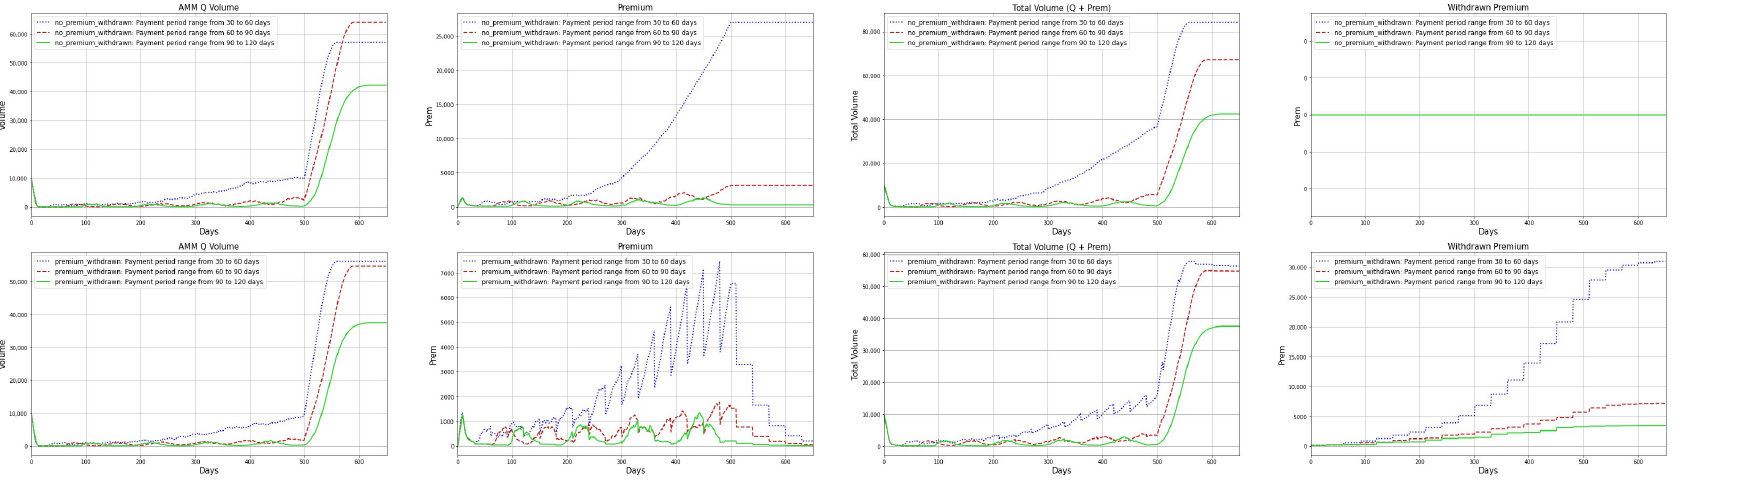
Figure A8. rkAMM Curves from simulation of scenario 3 and 30 days of withdrawal